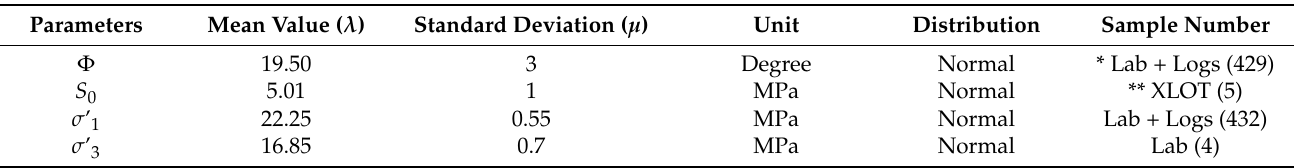
Table 1. The used database, including mean value ( λ ) and standard deviation ( µ ) of strength parameters ( ϕ and S 0 ) and effective stresses ( σ ’ 1 and σ ’ 3 )